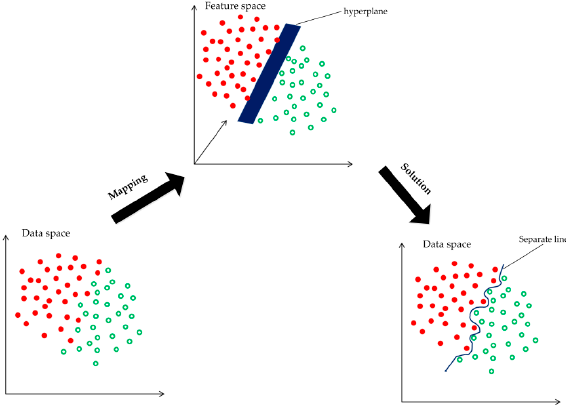
Figure 2. Illustration of nonlinear data separation by mapping to a higher dimensional feature space.